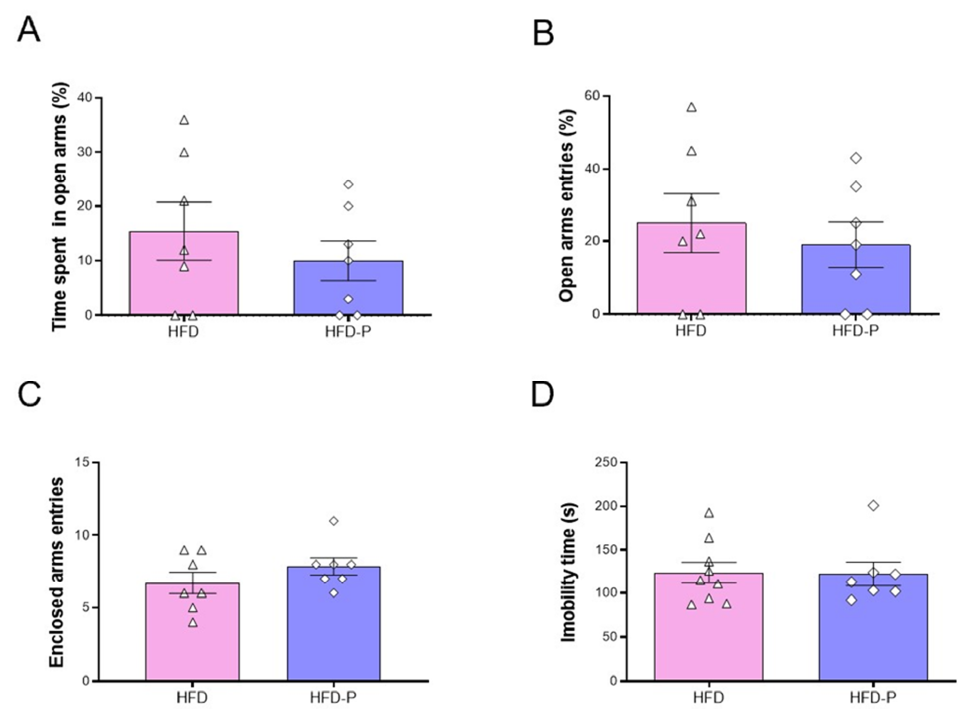
Figure 5. Comparative behavioral analyses of HFD-fed animals following oral administration of either saline vehicle (HFD) or Pep19 (1 mg/Kg; HFD-P). ( A – C ) Analysis of the effect of Pep19 on anxiety evaluated through the elevated plus-maze test. ( A ) Time spent in open arms (%). ( B ) Open arms entries (%). ( C ) Number of entries into Enclosed arms. ( D ) Analysis of the effect of Pep19 on depressive-like behavior evaluated by tail suspension test. Immobility time (s). Data expressed as mean ± SEM. n = 7–8 animals per group. No significant differences ( p < 0.05) were observed among different groups. Statistical analyses were performed using unpaired t -test ( A – D